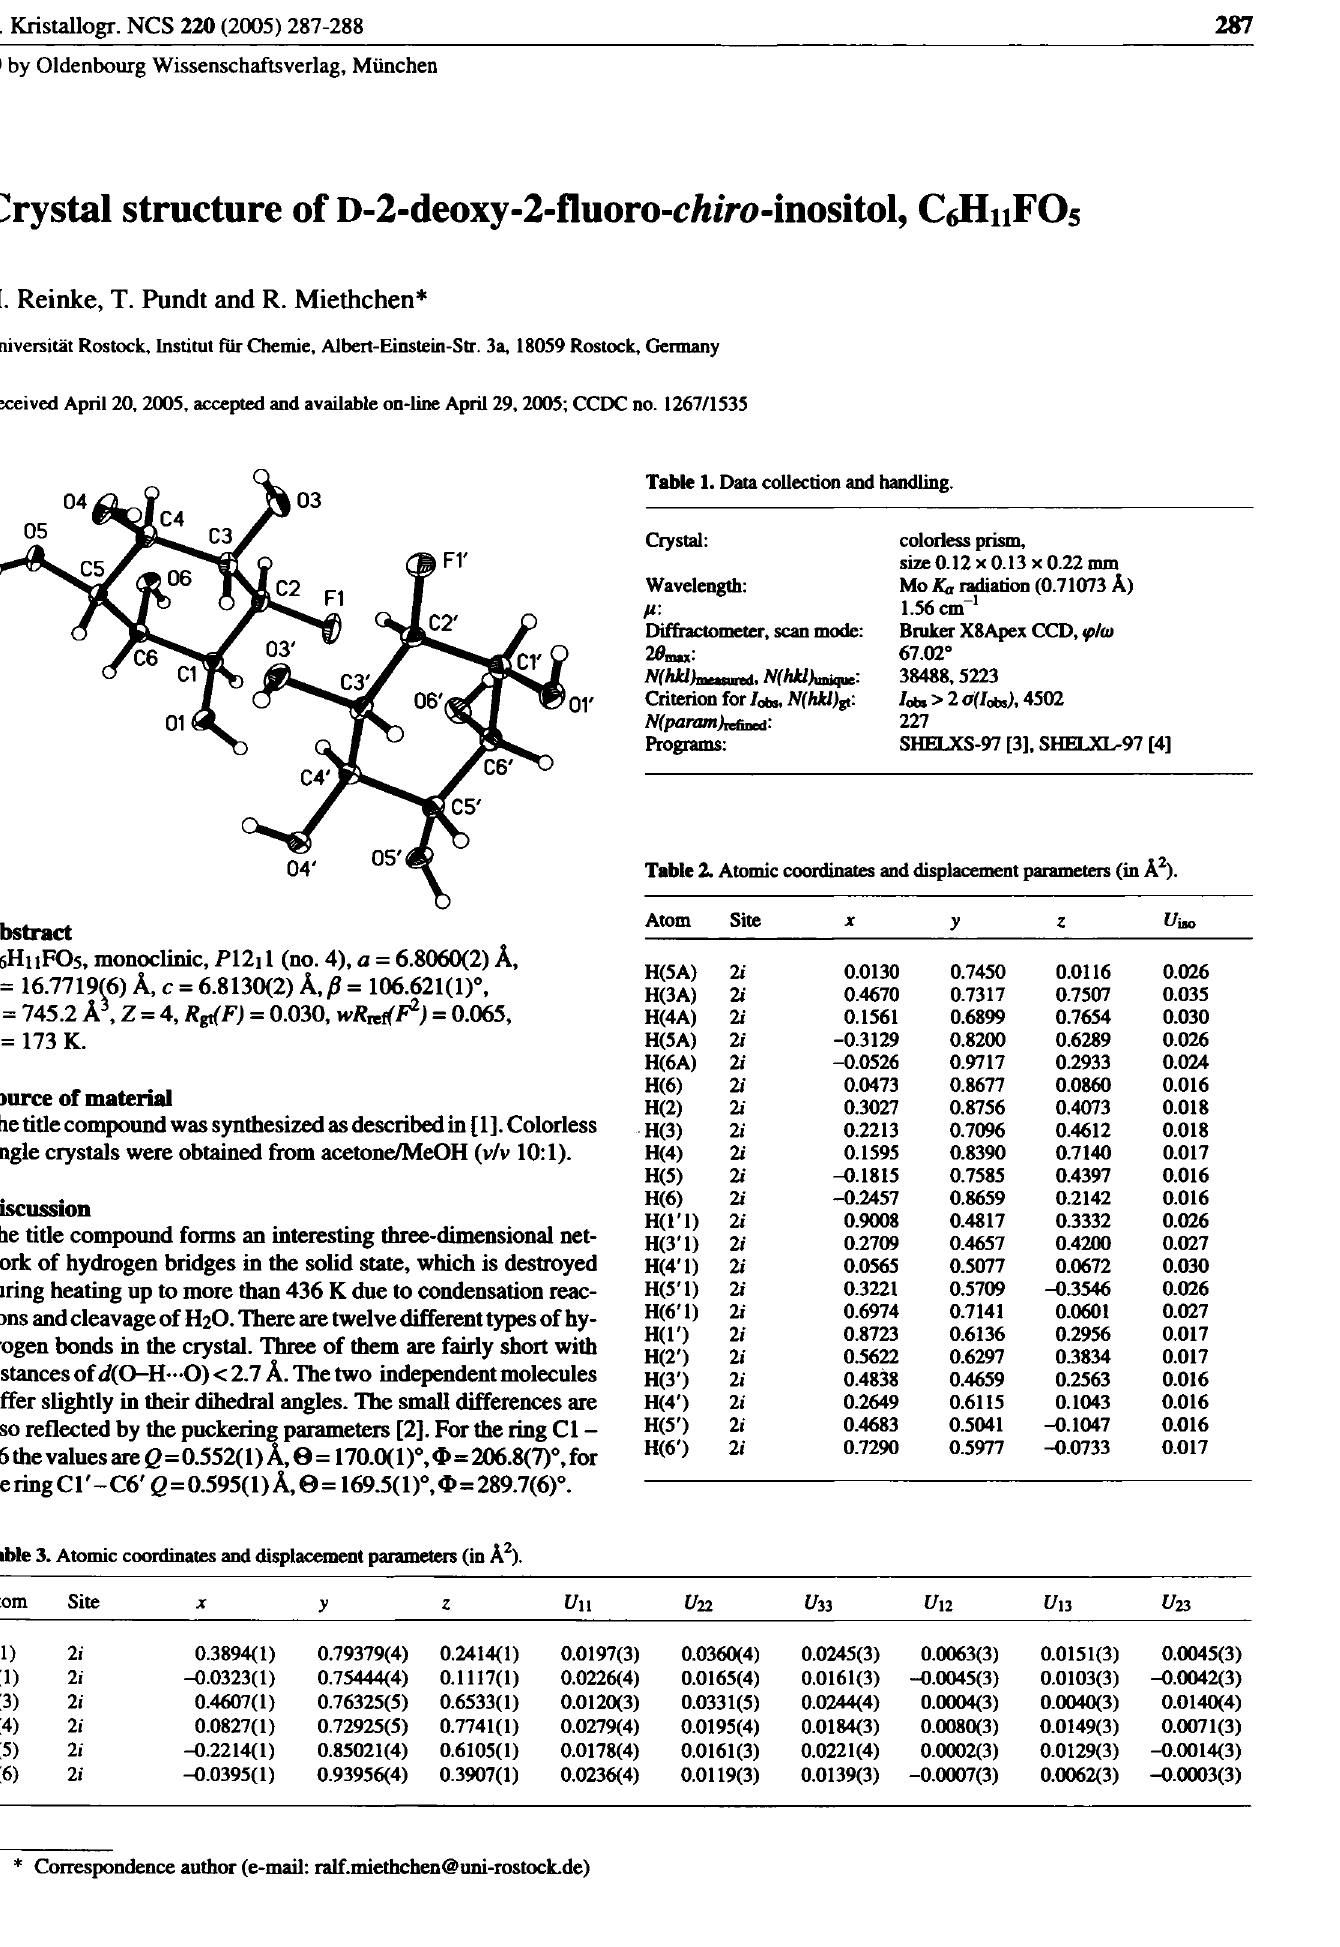
Table 1. Data collection and handling.